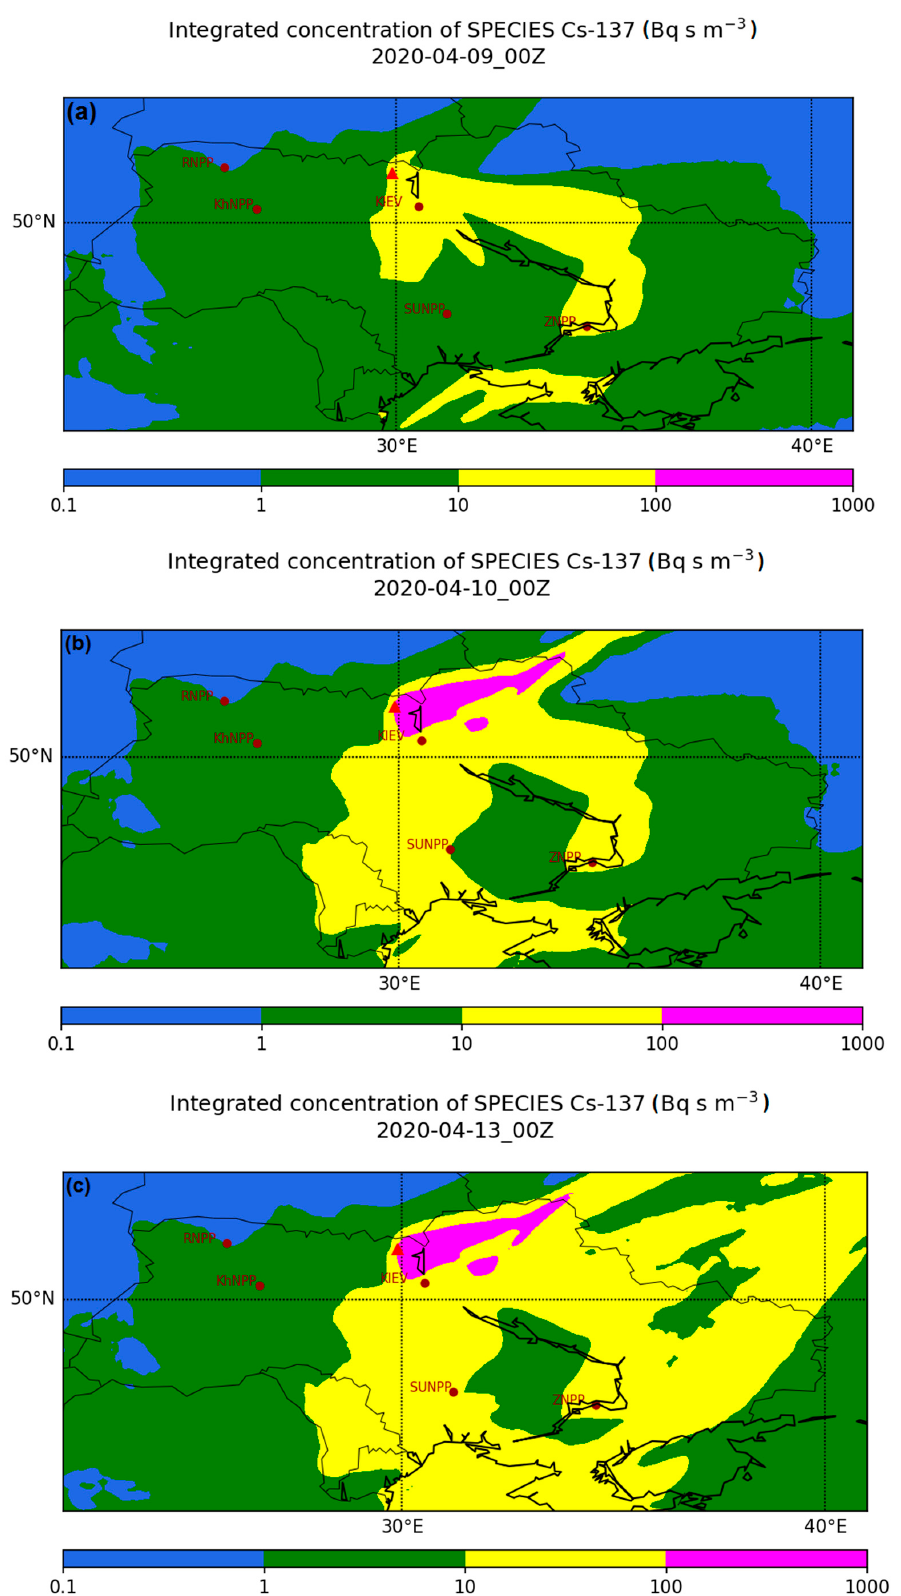
Figure 6. ( a ): Integrated Cs-137 activity concentration for the period 20200404 00:00 UTC to 9 April 2020 00:00 UTC. ( b ): For the period 4 April 2020 00:00 UTC to 10 April 2020 00:00 UTC. ( c ): For the period 4 April 2020 00:00 UTC to 13 April 2020 00:00 UTC. Red triangle indicates the source